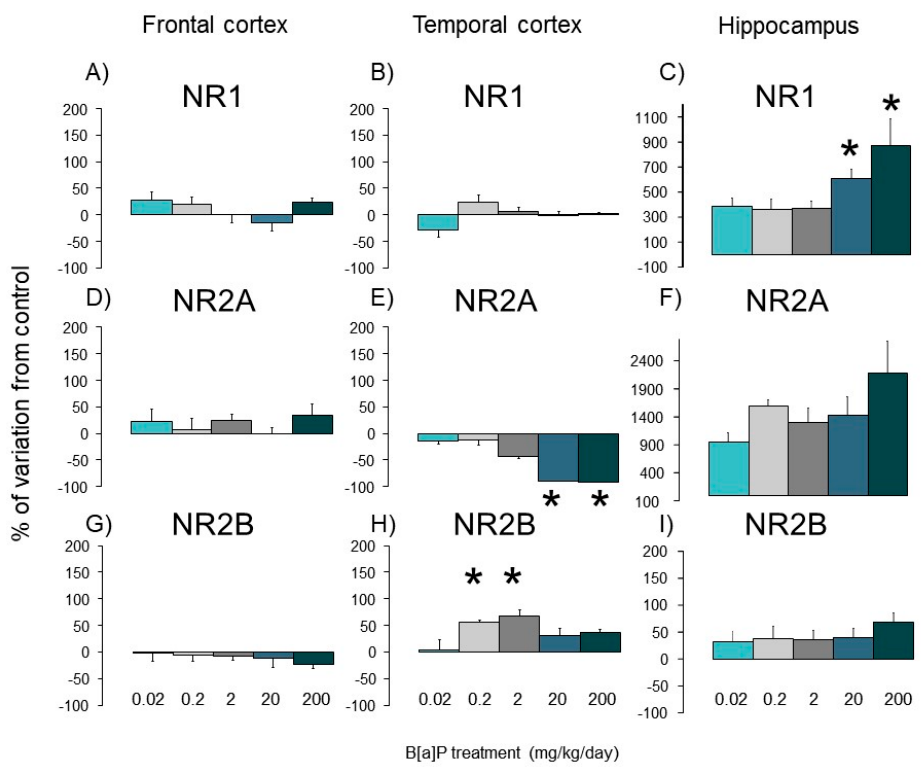
Figure 5. Levels of Nmda subunit (Nr1, Nr2a and Nr2b) expression in B[a]P-exposed mice via oral gavage at doses ranging from 0.02 to 200 mg/kg for 11 consecutive days. ( A , D , G ): respectively Nr1, Nr2a and Nr2b in frontal cortex. ( B , E , H ): respectively Nr1, Nr2a and Nr2b in Temporal cortex. ( C , F , I ): respectively Nr1, Nr2a and Nr2b in hippocampus. Nmda subunits are shown as copies/10 2 copies Gapdh. Data were reported as mean ± SEM (4 mice per group). * p < 0.05 vs. controls (SNK-t test for multiple comparisons).